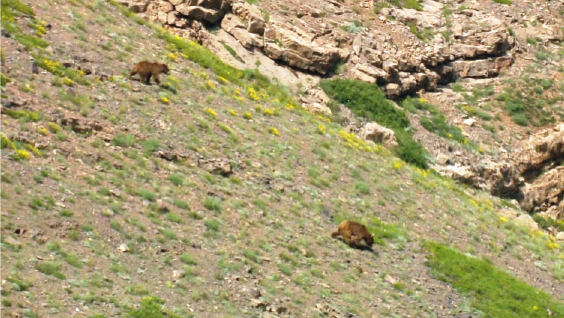
Image 4. A female Brown Bear (left) tries to stop an adult male (right) from killing cubs which were chased by the male (not seen inside the picture). The family survived (WPI/ICS/F.